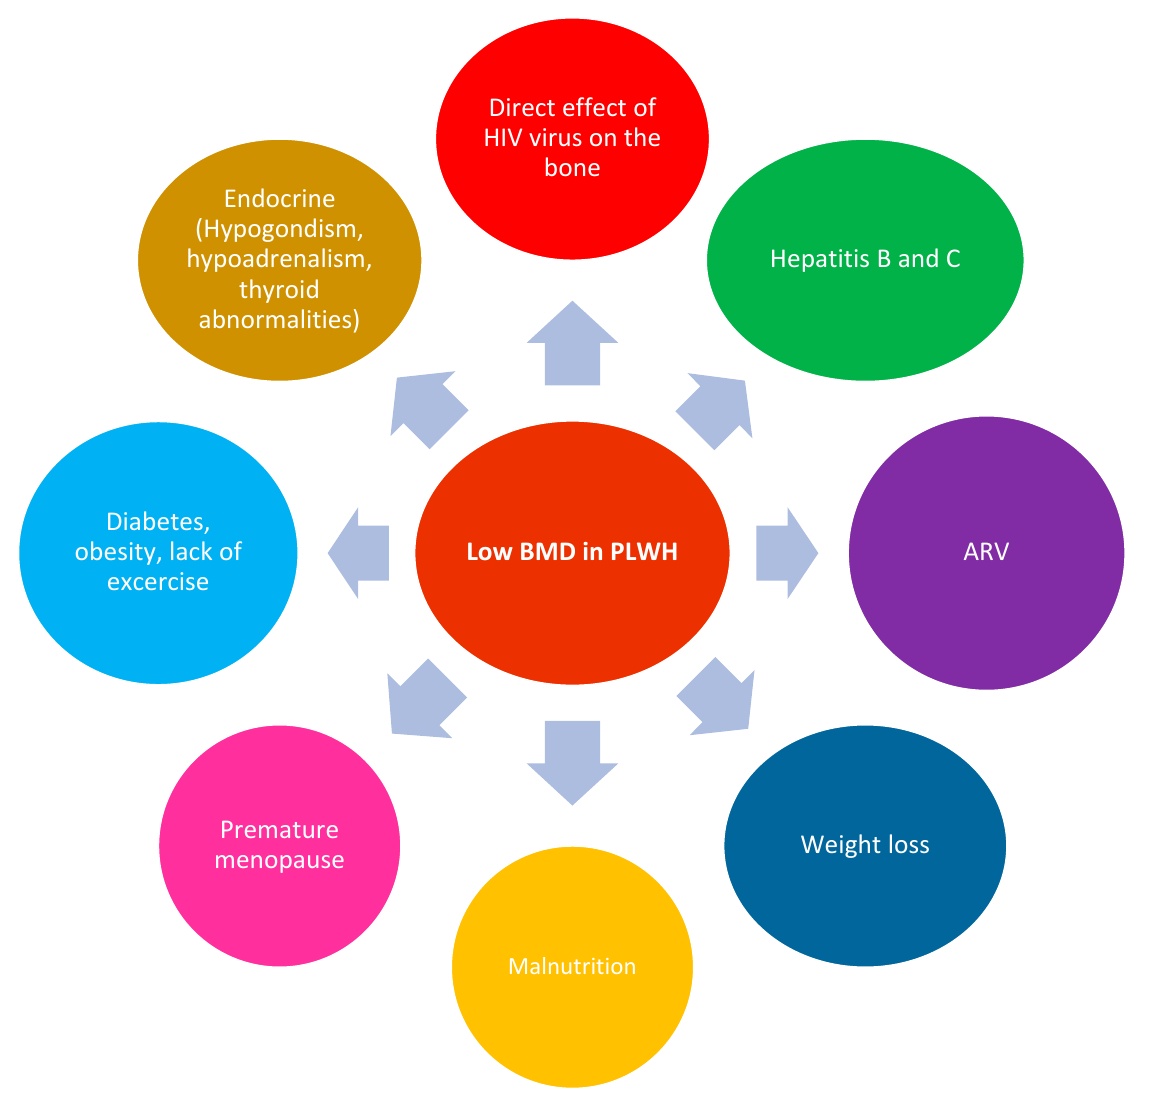
Figure 2. Different factors that may lead to low BMD in PLWHIV.